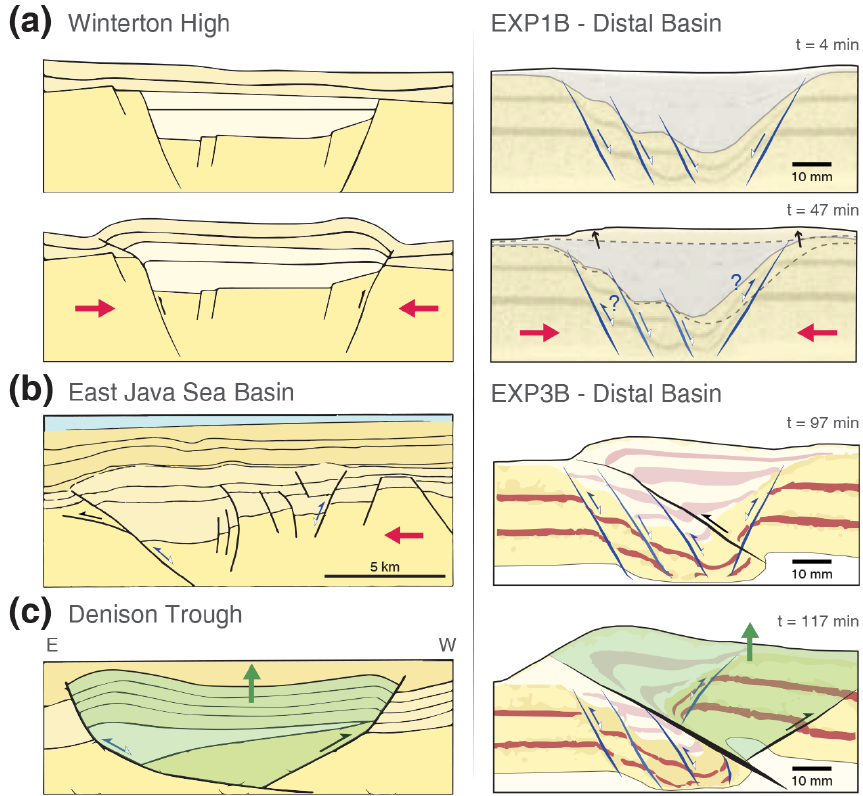
Figure 13. Side-by-side comparison between selected natural examples and small-scale observations from experimental results. (a) Winterton High and EXP1B distal basin. (b) Eastern Java Sea basin and EXP3B distal basin, early stages. (c) Denison Trough and EXP3B distal basin, late stages. Red arrows indicate compressional forces. The section highlighted in green in panel (c) indicates pop-up structures being uplifted during